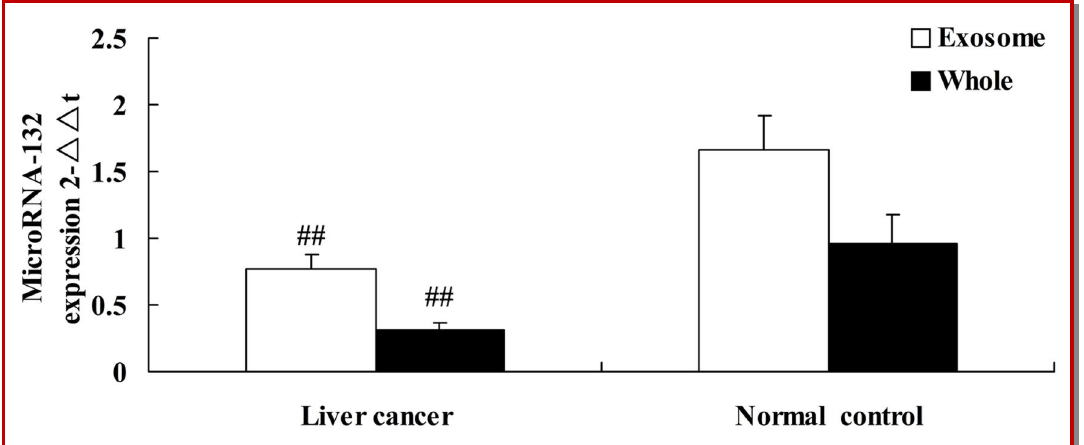
Figure 1: Correlations of microRNA-132 expression and patient clinicopathologic characteristics ## p<0.01 compared with normal group